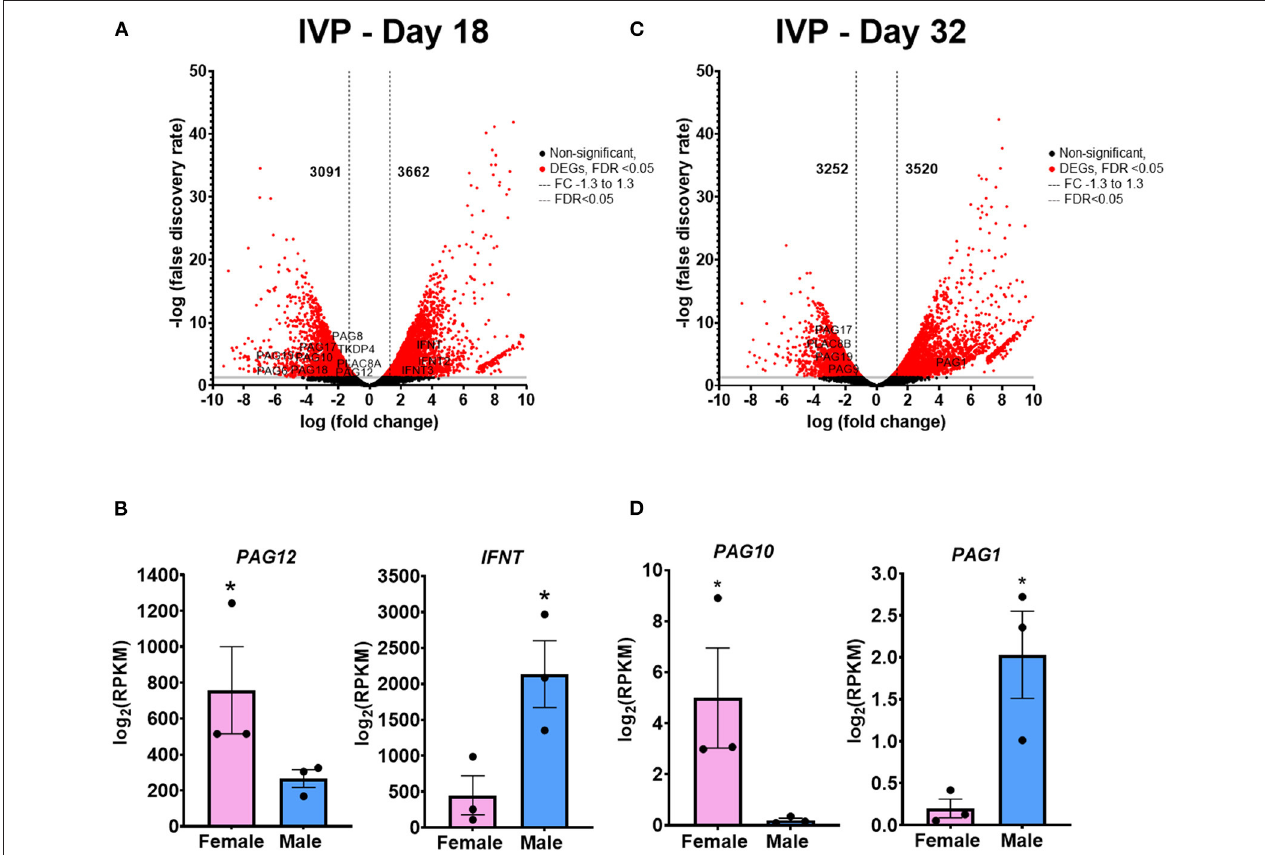
FIGURE 4 | Differentially expressed genes (DEGs) of the IVP extraembryonic membranes comparing male vs. female. (A) Volcano plot representing the number of DEGs comparing male vs female on day 18 conceptuses. Black dots are not significant (FDR > 0.05), Red dots are significant (FDR < 0.05), Gray line at FDR = 0.05, Black dashed lines delimit Fold Change at − 1.3 to 1.3. (B) Representative genes upregulated in the female conceptuses ( PAG12 ) and in male conceptuses ( IFNT ). (C) Volcano plot representing the number of DEGs comparing male vs female on day 32 conceptuses. Black dots are not significant (FDR > 0.05), Red dots are significant (FDR < 0.05), Gray line at FDR = 0.05, Black dashed lines delimit FC − 1.3 to 1.3. (D) Representative gene upregulated in the female conceptuses ( PAG10 ) and in the male conceptuses ( PAG1 ). *FDR < 0.05. IVP, in vitro produced